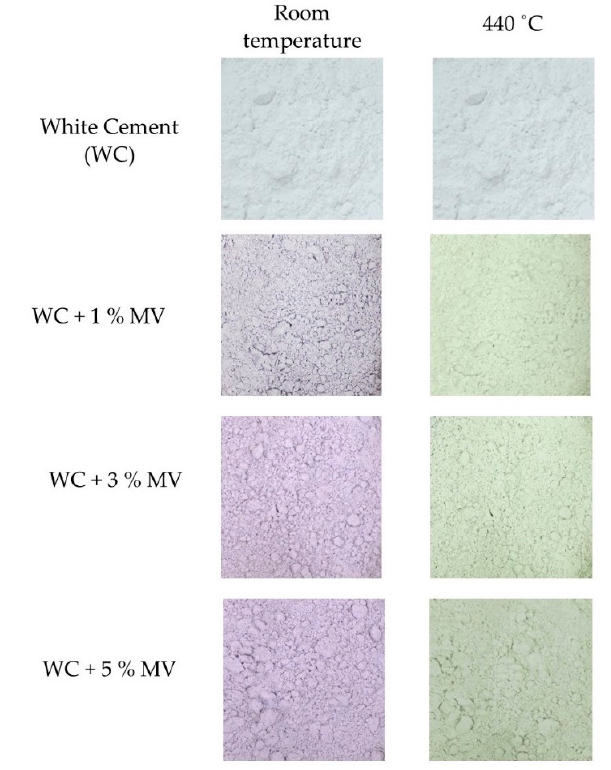
Figure 6. Color changes in the white cement and MV mixed samples exposed to different temperatures (Scale: 1000 × 1000 pixels).